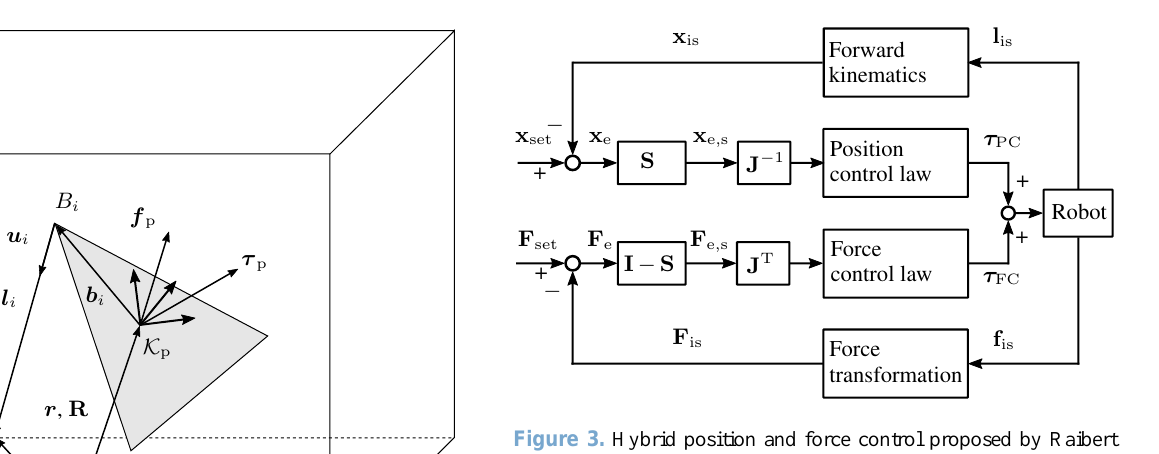
Figure 2. General kinematic parameters